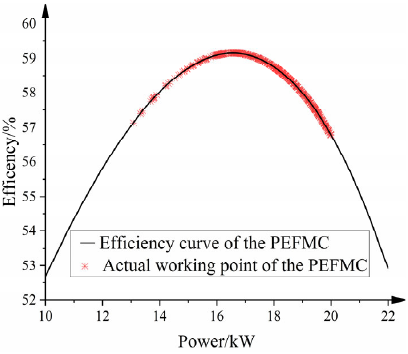
Figure 12. The actual working point of the hydrogen fuel cell.